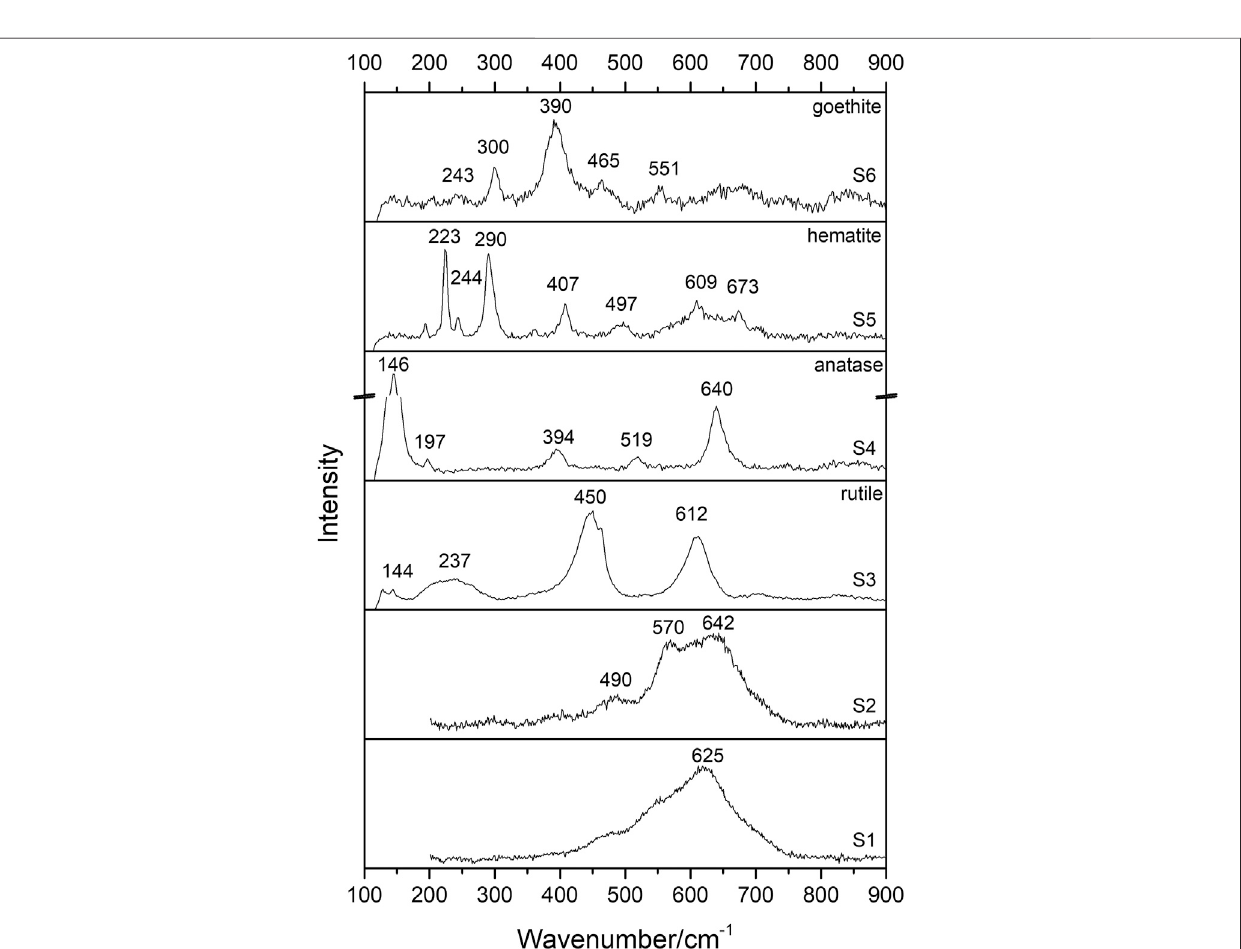
Frontiers in Earth Science |